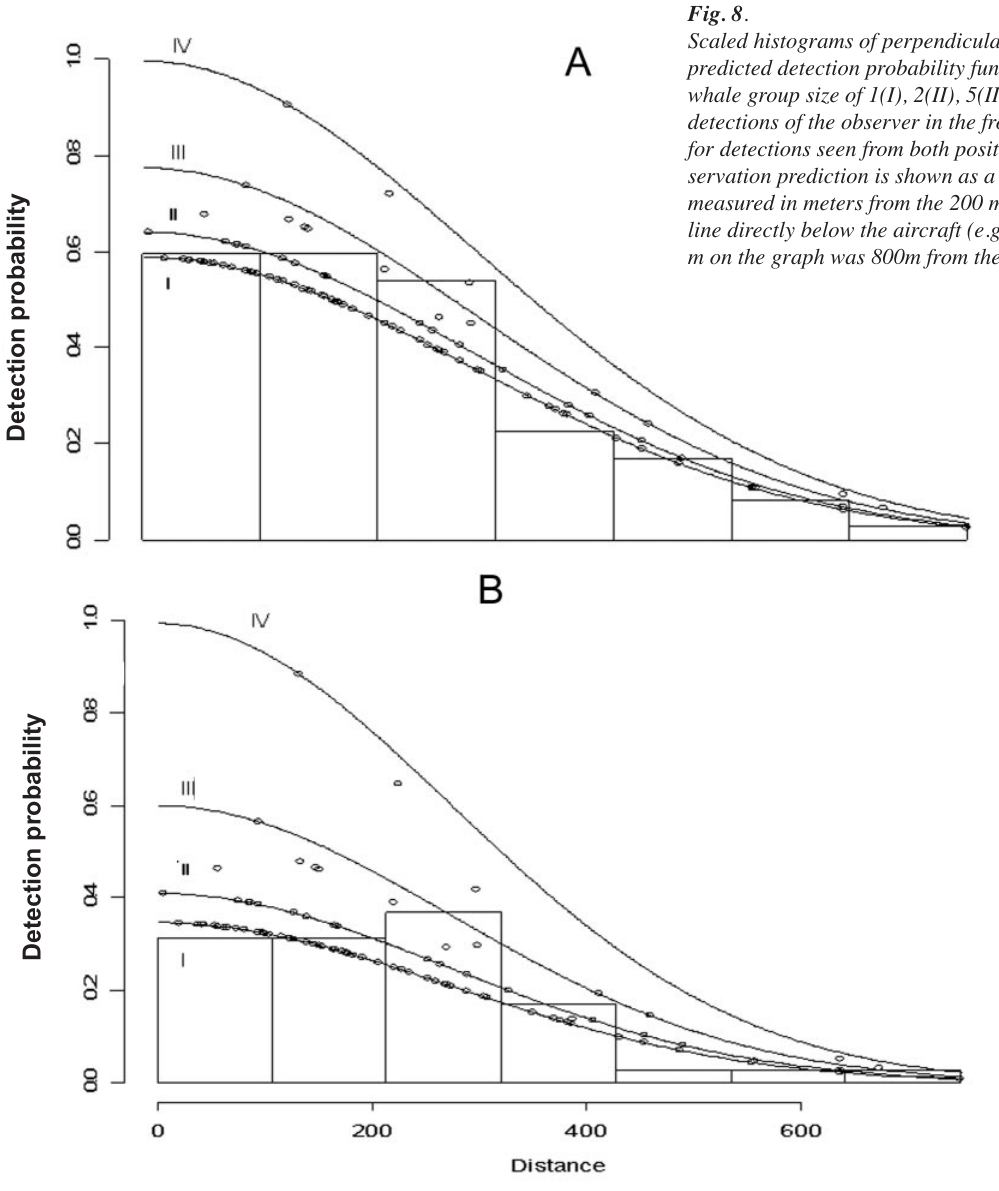
Fig. 8 . Scaled histograms of perpendicular distances and predicted detection probability functions for beluga whale group size of 1(I), 2(II), 5(III) and 25(IV) for detections of the observer in the front seat (A) and for detections seen from both positions (B). Each ob- servation prediction is shown as a circle. Distance is measured in meters from the 200 m offset from the line directly below the aircraft (e.g. a distance of 600 m on the graph was 800m from the